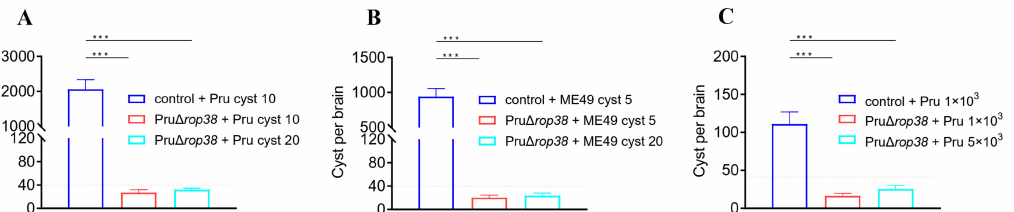
Figure 6. Effect on brain parasite burden when challenged with T. gondii type II strains. The brain from vaccinated and control mice were harvested after challenge with 30 days, and cysts were observed by IFA and then the number of cysts were determined by DBA-FITC staining. ( A ) Pru cyst challenge (20 and 10), ( B ) ME49 cyst challenge (20 and 5), and ( C ) Pru tachyzoite (5 × 10 3 and 1 × 10 3 ) challenge, respectively. ( n = 5; presented as the mean of cyst number ± SD; *** p < 0.001; one-way ANOVA with